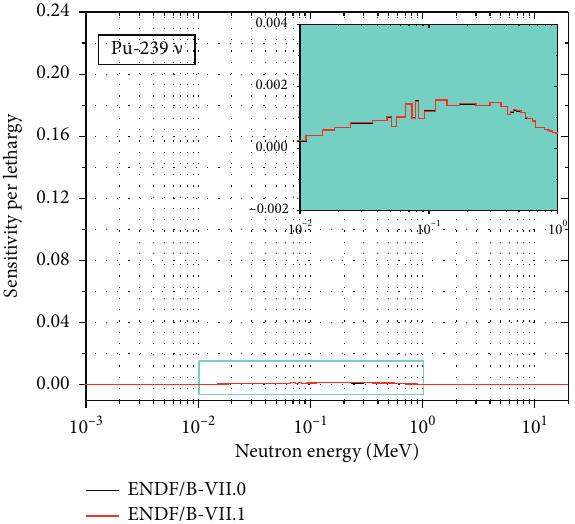
Figure 14: Energy-dependent sensitivities of k to 23 Na elastic eff cross